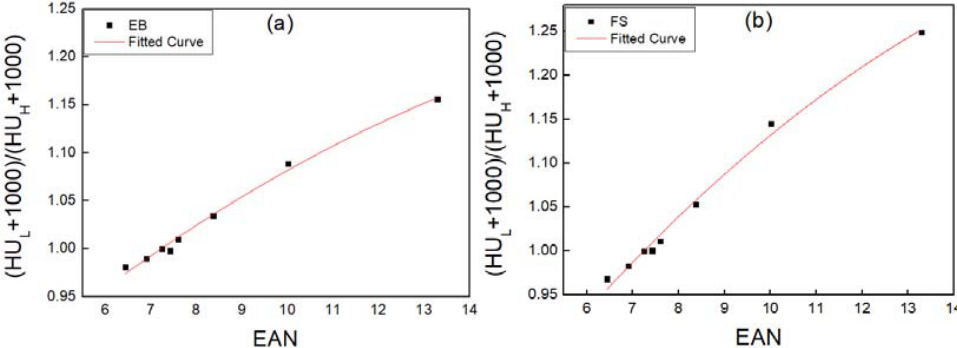
Figure 4. Stoichiometric curve fitting results as a function of effective atomic number (EAN) and the linear attenuation ratio for ( a ) energy bin (EB) and ( b ) full spectrum (FS) mode. Table 2. Spectral parameters for extraction of effective atomic number (EAN) by stoichiometric calibration of dual-energy image in energy bin (EB) and full spectrum (FS) mode. Material